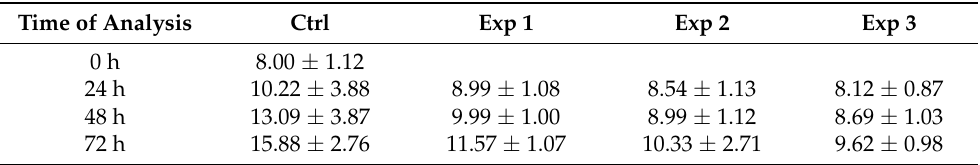
Table 3. Occurrence of dead boar spermatozoa (%) following exposure to selected semen extenders during different time intervals.